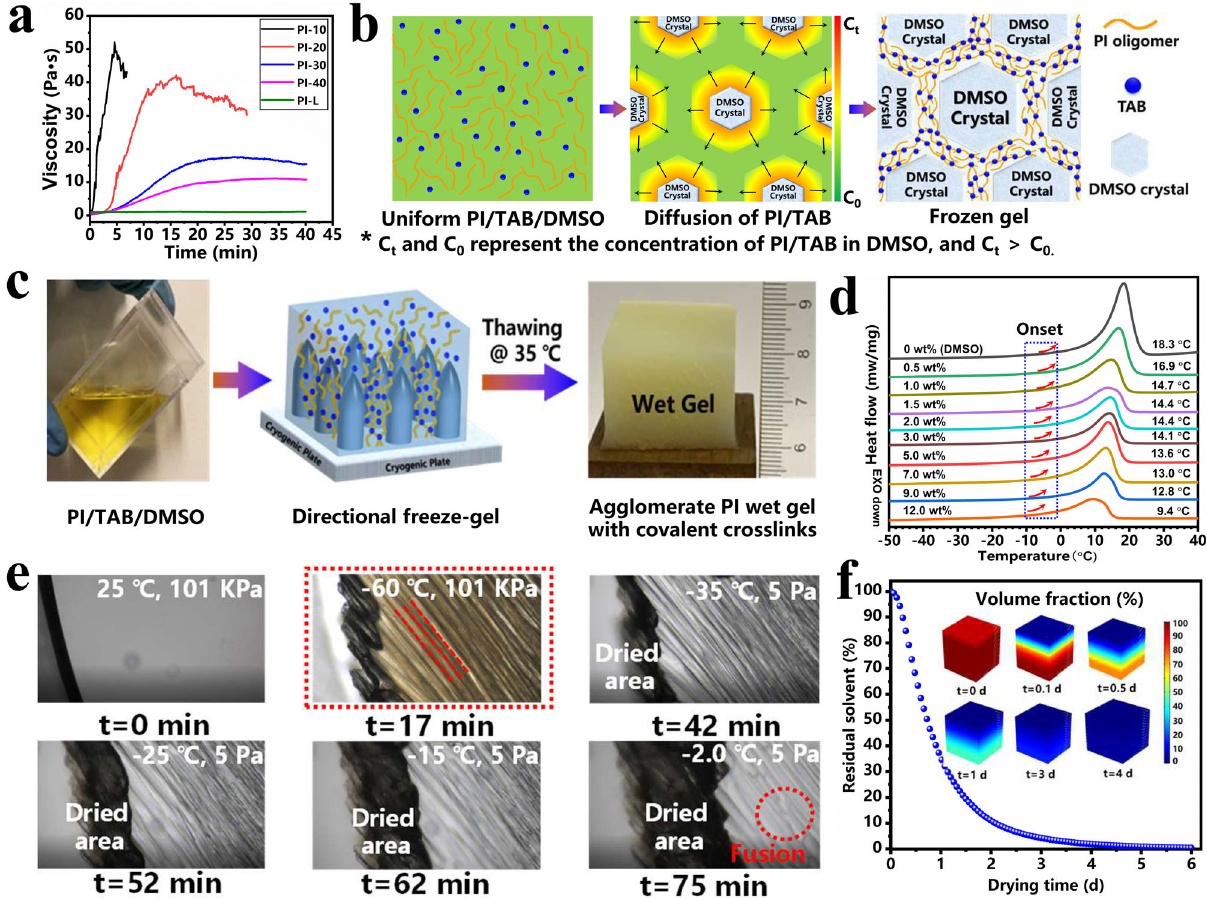
Fig. 2 Fabrication process of covalently cross-linked PI aerogel with DMSO solvent. a Shearing viscosity curves of 6 wt% PI oligomers solutions with different contents of TAB cross-linker under a constant shearing rate. b Mechanism of the directional freeze gelation process. c Optical images after thawing frozen gel of PI/TAB/DMSO with a solid content of 0.5 wt%. d DSC cures of DMSO solvent containing different content of PI oligomers with polymerization degree of 10. e Microscopy images of the pre-freezing and freeze-drying process from the microscopy system of vacuum freeze-drying based on PIM-10 with a 0.5 wt% solid content in DMSO solvent. f Simulation of residual DMSO during the freeze-drying process by fi nite element